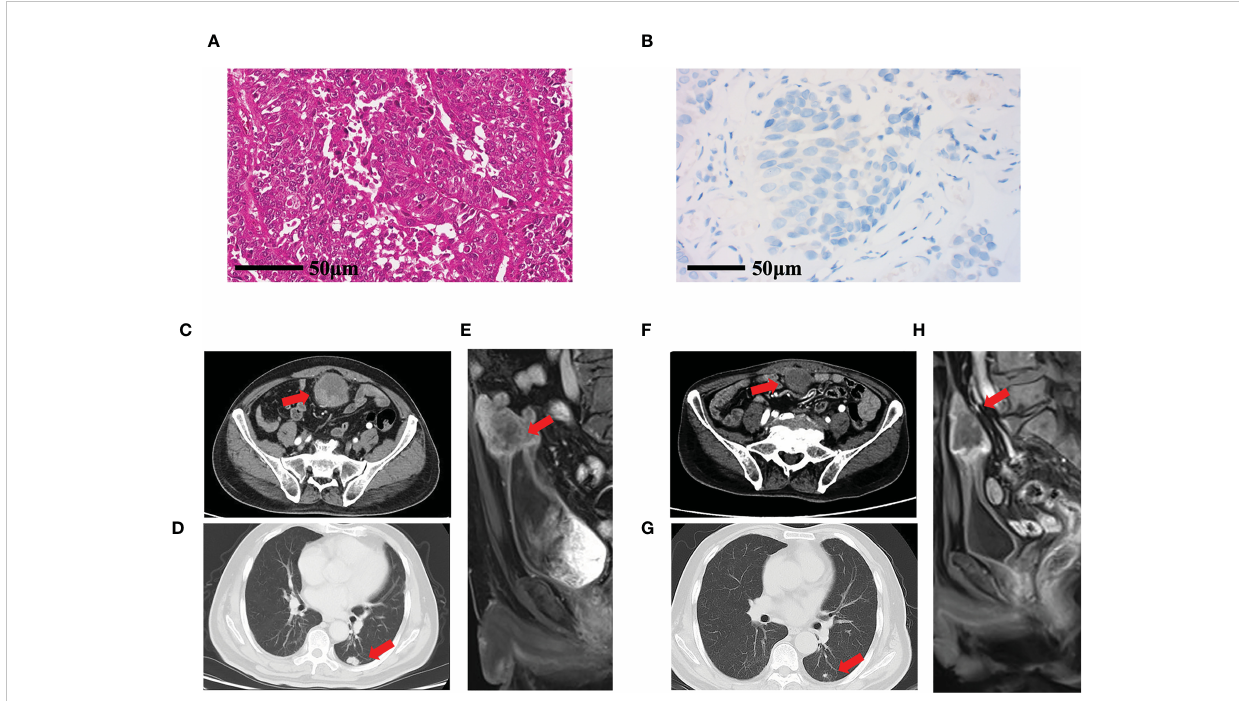
FIGURE 2 Pathological and imaging examination of case 2. (A) Pathological results of hematoxylin and eosin cytology staining of a tumor biopsy. (B) PD-L1 expression evaluated by immunohistochemistry. (C) Abdominal enhanced CT showing a round nodule measuring 5.4 × 5.5 cm with clear boundaries at the top of the bladder (red arrow). (D) Chest CT showing a 1.7-cm nodule in the inferior lobe of the right lung (red arrow). (E) Pelvic MRI sagittal axis T2WI showing that the tumor at the base of the bladder was 6.5 × 5.5 cm, with a moderately high signal shadow. (F) After 16 cycles of treatment, enhanced CT of the abdomen revealed that the tumor was 3.8 × 3.7 cm (red arrow); (G) Chest CT showed that the size of the mass in the lower lobe of the right lung was reduced to 0.8 cm (H) Pelvic MRI, sagittal axis, and T2WI showed that the tumor in the bladder base was 5.0 × 3.8 cm, with a moderately high signal shadow (red arrow). T2WI, T2-weighted